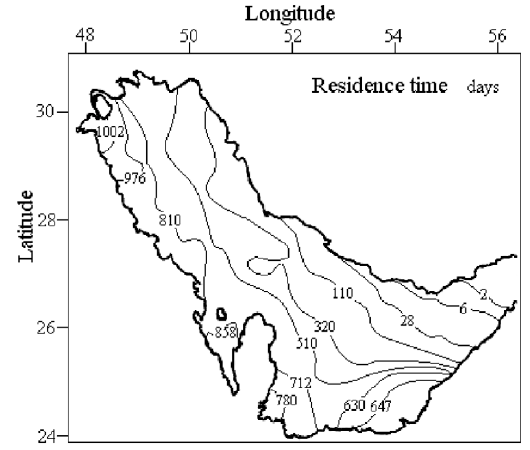
Figure 3. Residence times calculated for sources within the Gulf (from [16]).